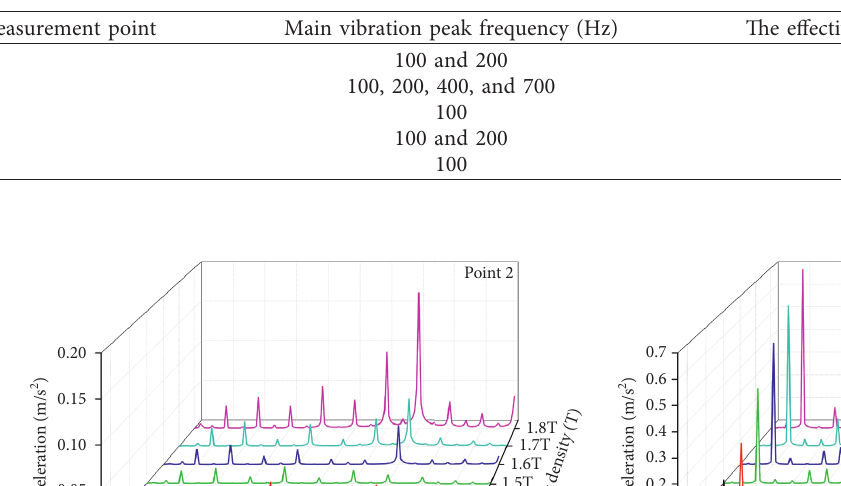
Figure 12: Vibration time-domain and spectrum plots of different measurement points at 1.3T magnetic density. (a) Vibration time- domain diagram. (b) Vibration frequency-domain diagram. Table 1: Vibration results of different measurement points under the magnetic density of 1.3 T.